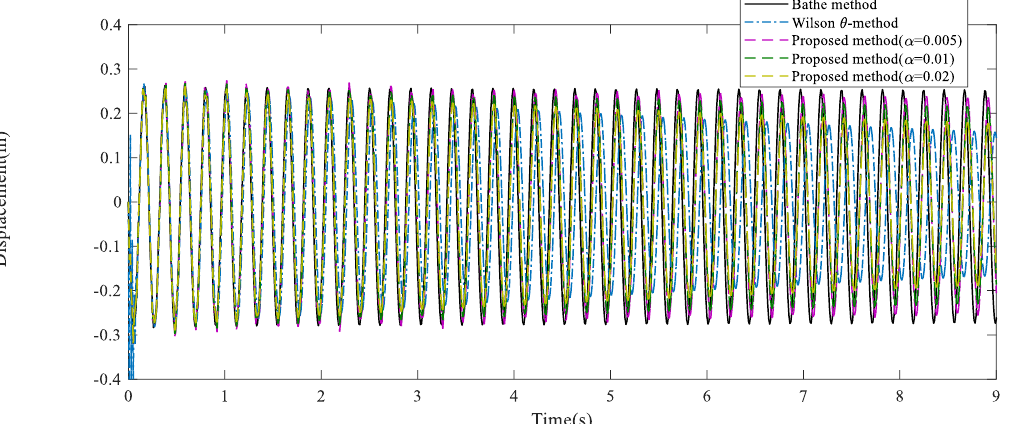
Figure 17. Vertical displacement responses of Point A with the Wilson method, Bathe method, and the proposed method when ∆ t = 0.01 s.